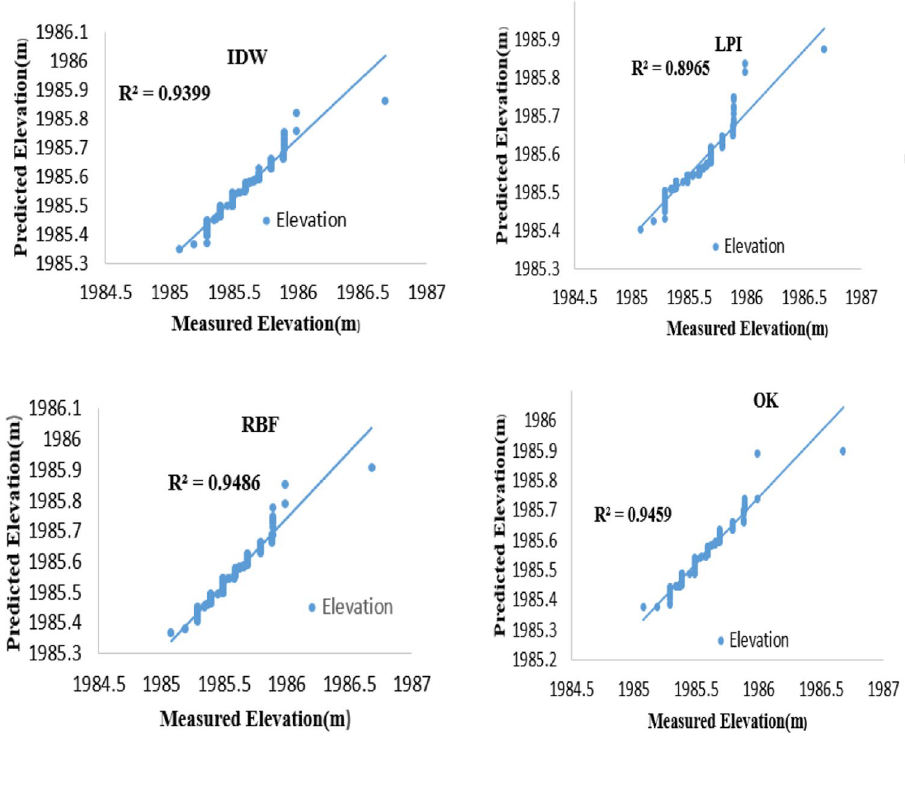
Fig. 8 Adebra NSR 2020 bathymetry survey (raster) map after RBF method by water